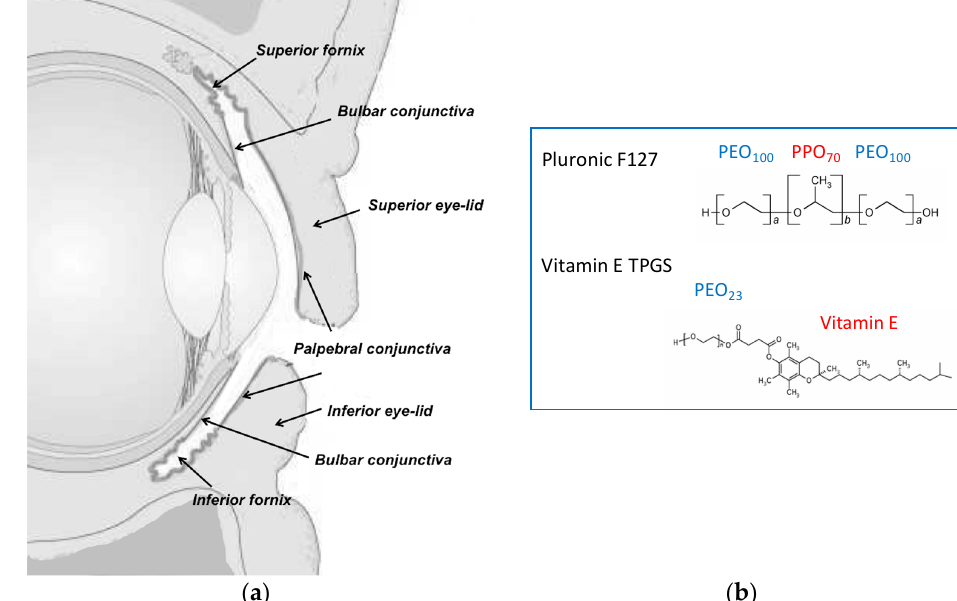
Figure 1. ( a ) Scheme of the vertical section of the eye. Reprinted with permission from Pescina et al. [29]. Copyright Taylor & Francis, 2017. ( b ) Chemical structure of the polymeric surfactants used in